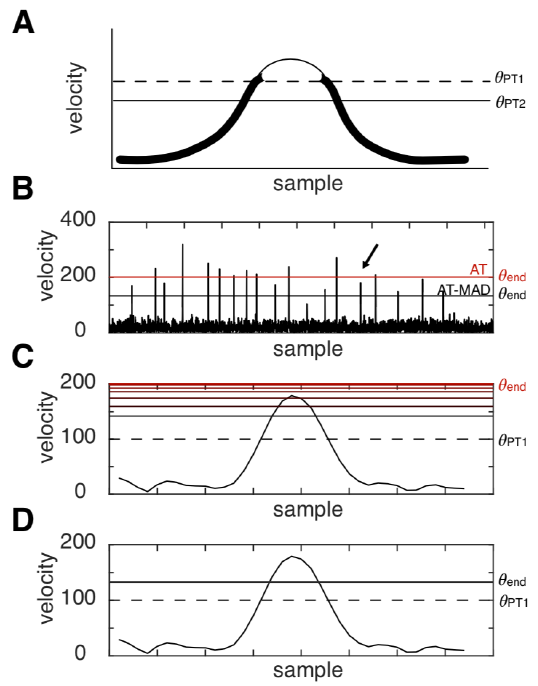
Figure 1. Example where adaptive thresholding detects saccades in a data-driven manner, but can fail with non-robust statistics (A) Schematic of AT algorithm. The threshold for detection is initialized at q PT1 (dashed line). All points below this (thick line segments of the curve) are then used to calculate q PT2 (solid horizontal line), a new threshold used on the next iteration to determine the next threshold This algorithm proceeds until it converges to a solution. (B) Velocity of simulated scanpath with 20 low amplitude saccades. Horizontal lines depict the final threshold q end as determined by the AT algorithm (red) and AT-MAD algorithm (black). The AT-MAD algorithm finds a lower bound than AT, though still well above the background noise. ( C-D) Example saccade that was not detected by the AT algorithm (C) but was detected by the AT-MAD algorithm (D), corresponding to the arrow in (B). (see Figure 5E-J for examples from human data). The initial threshold is depicted as a dashed line. Solid, red horizontal lines represent the threshold on successive iterations, with darker (lighter) lines showing earlier (later) iterations. Notice that it increases beyond the initial threshold, but the AT-MAD algorithm successfully stops iterating, whereas AT does